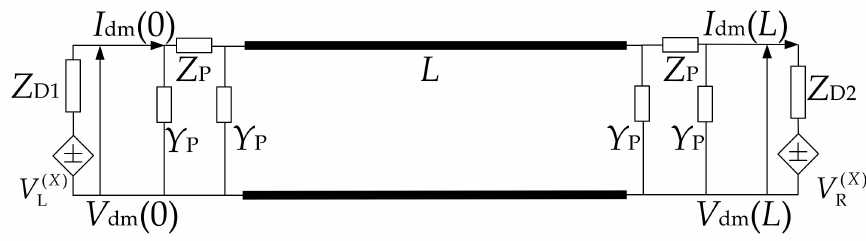
Figure 4. DM circuit in radiation and injection